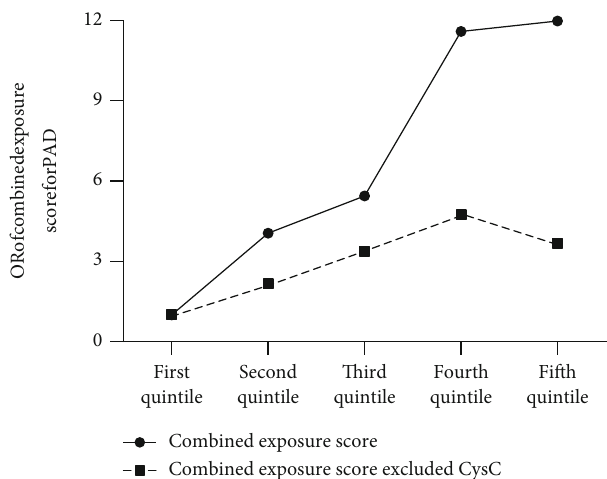
Figure 2: The odds ratio of developing PAD among the quintiles of the combined exposure score. Combined exposure score was obtained based on risk points of age, sex, smoking status, diabetic course, platelets (PLT), red blood cell (RBC), white blood cell (WBC), and cystatin C (CysC). Combined exposure score excluded CysC was calculated based on risk points of age, sex, smoking status, diabetic course, PLT, RBC, and